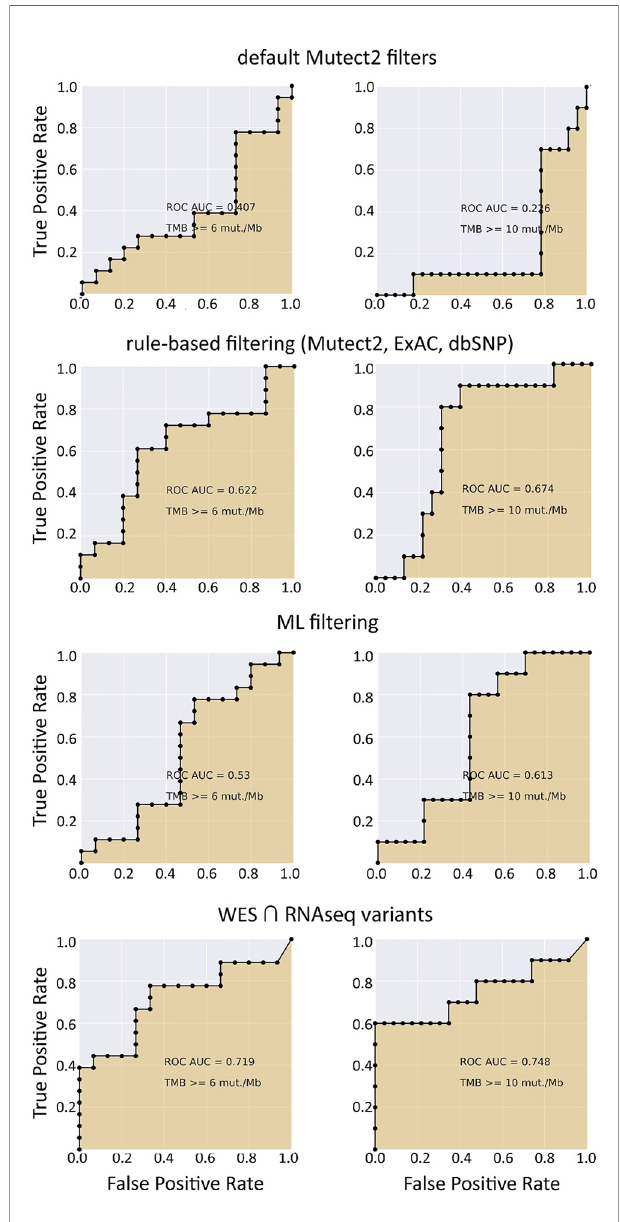
FIGURE 9 | ROC AUC scores for predicting WES-TMB per megabase with RNAseq-TMB per megabase (experimental low coverage transcriptomes, n =